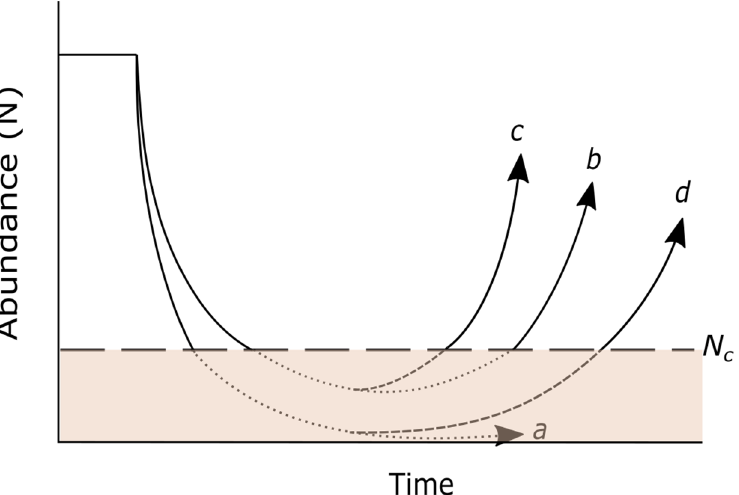
Figure 1. Conceptual diagram of facilitated adaptation. Population abundance (N) and extinction risk in the presence or absence of evolution. Following the conventions of Gomulkiewicz and Holt [57], growth is density independent, and N C represents a threshold abundance below which the possibilities of extinction are high. Dashed portions of curves represent time at greatest risk of extinction for populations faced with a shift in their selective environment: (a) population declines to extinction in the absence of relevant standing genetic variation or new beneficial mutations; (b) evolution is insufficient to prevent the population from entering the extinction risk zone, but allows the population to grow out of that zone if new beneficial allelic combinations or mutations arise; (c) reinforcement with pre ‐ adapted individuals provides beneficial alleles; this allows the population to avoid extinction and to reduce the recovery time; (d) reinforced individuals provide beneficial alleles, but also maladapted alleles.